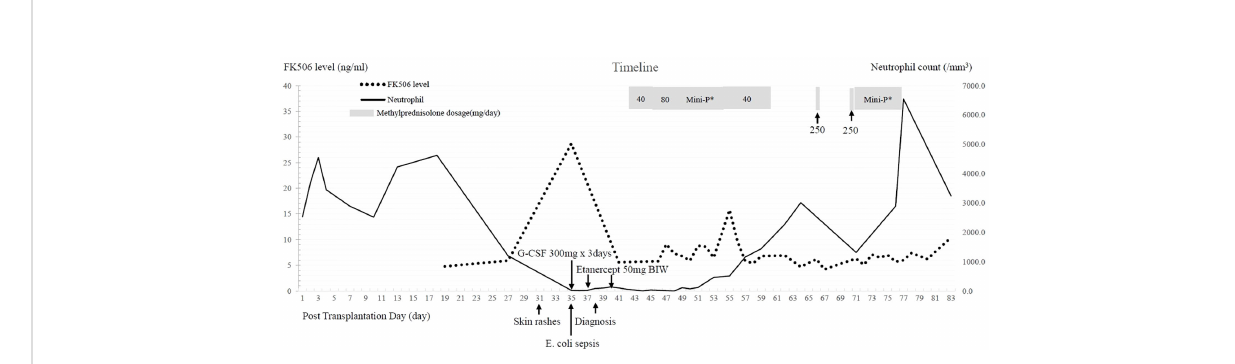
FIGURE 3 Clinical course after liver transplantation. FK506: tacrolimus, E. coli : Escherichia coli , G-CSF: granulocyte colony-stimulating factor Mini-P*: Methylprednisolone mini-pulse therapy with dose tapering-methylprednisolone 200 mg divided in four doses per day, then 160 mg, 120 mg, and 80 mg, followed by 40 mg divided by two doses per